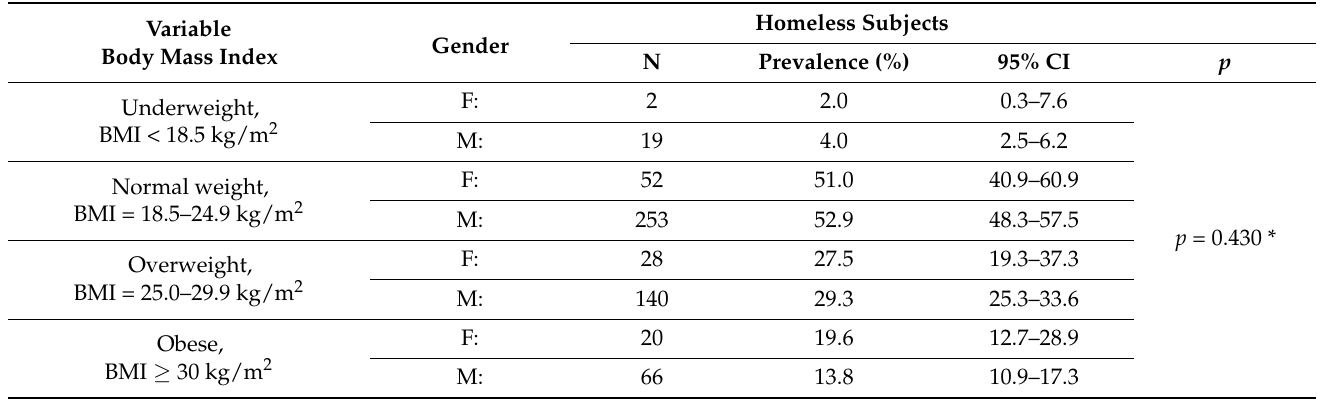
Table 3. BMI in the homeless people according to gender in WHO